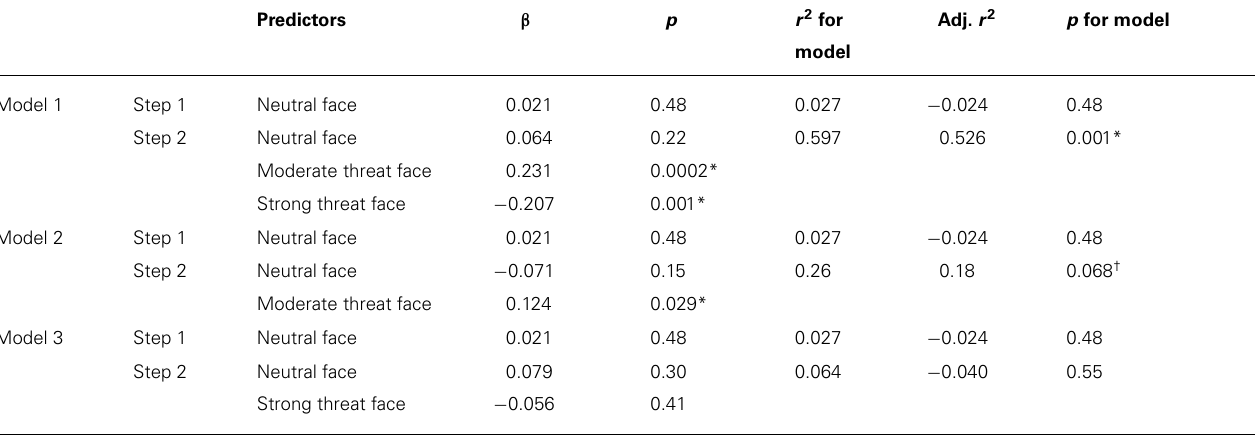
Table 2 | Hierarchical regression analyses examining prediction of trait anxiety by target identification RTs as a function of prior distractor type (long ISI trials only).